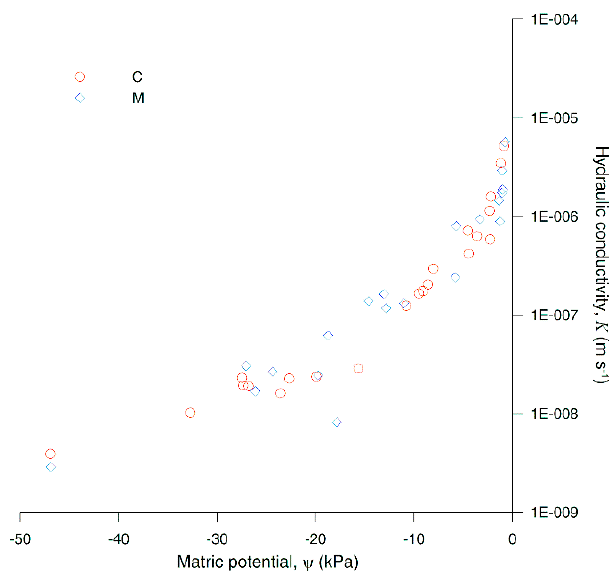
Figure 10. Hydraulic conductivity, K ( θ ), measured by the QSC method for lithotypes C and M.